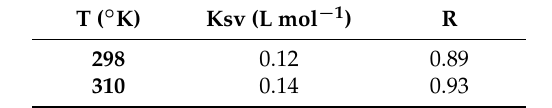
Table 1. Stern-Volmer dynamic quenching constants for the molybdenum [Mo 6 Cl 14 ] 2 − clusters and albumin. R is the correlation coefficient.